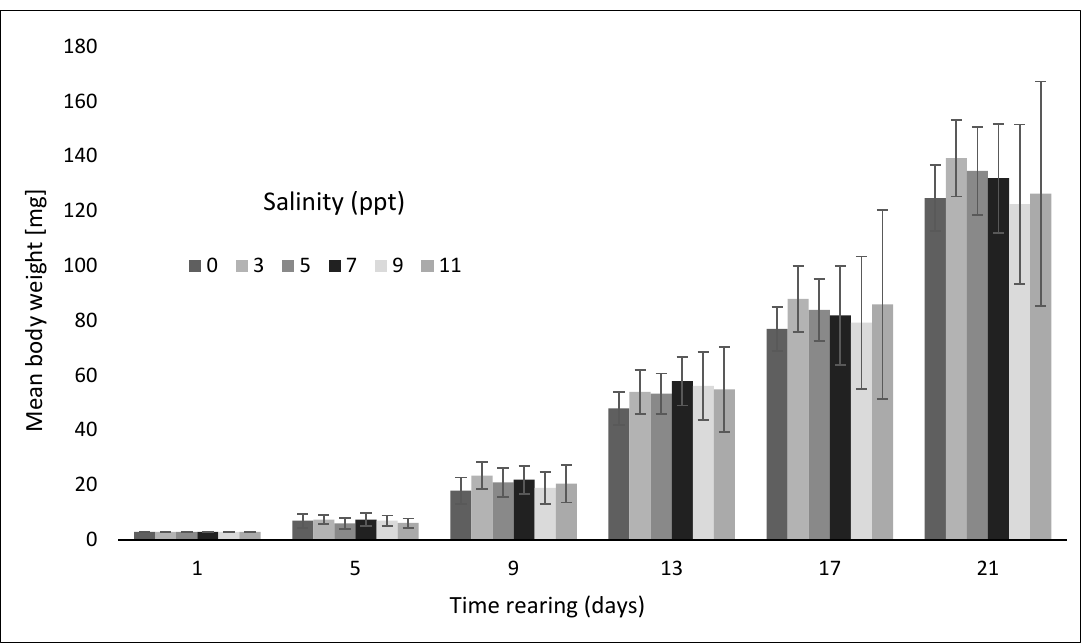
Figure 3. Average body weight increases in asp larvae Leuciscus aspius (L.) reared in water with various salinity levels.